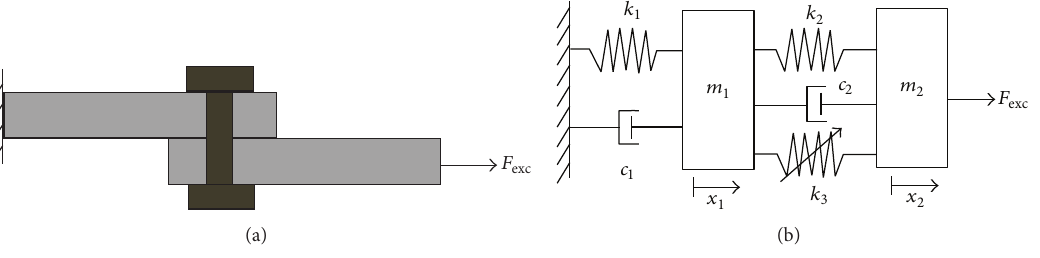
Figure 2: Two-degree-of-freedom (DOF) nonlinear model.